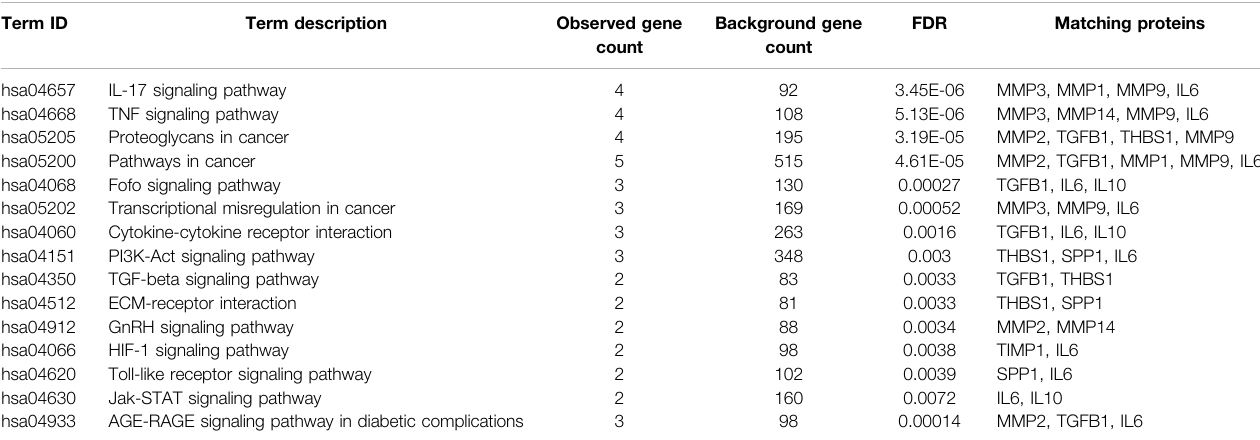
TABLE 6 | KEGG enrichment of TIMP1 retrieved from the STRING